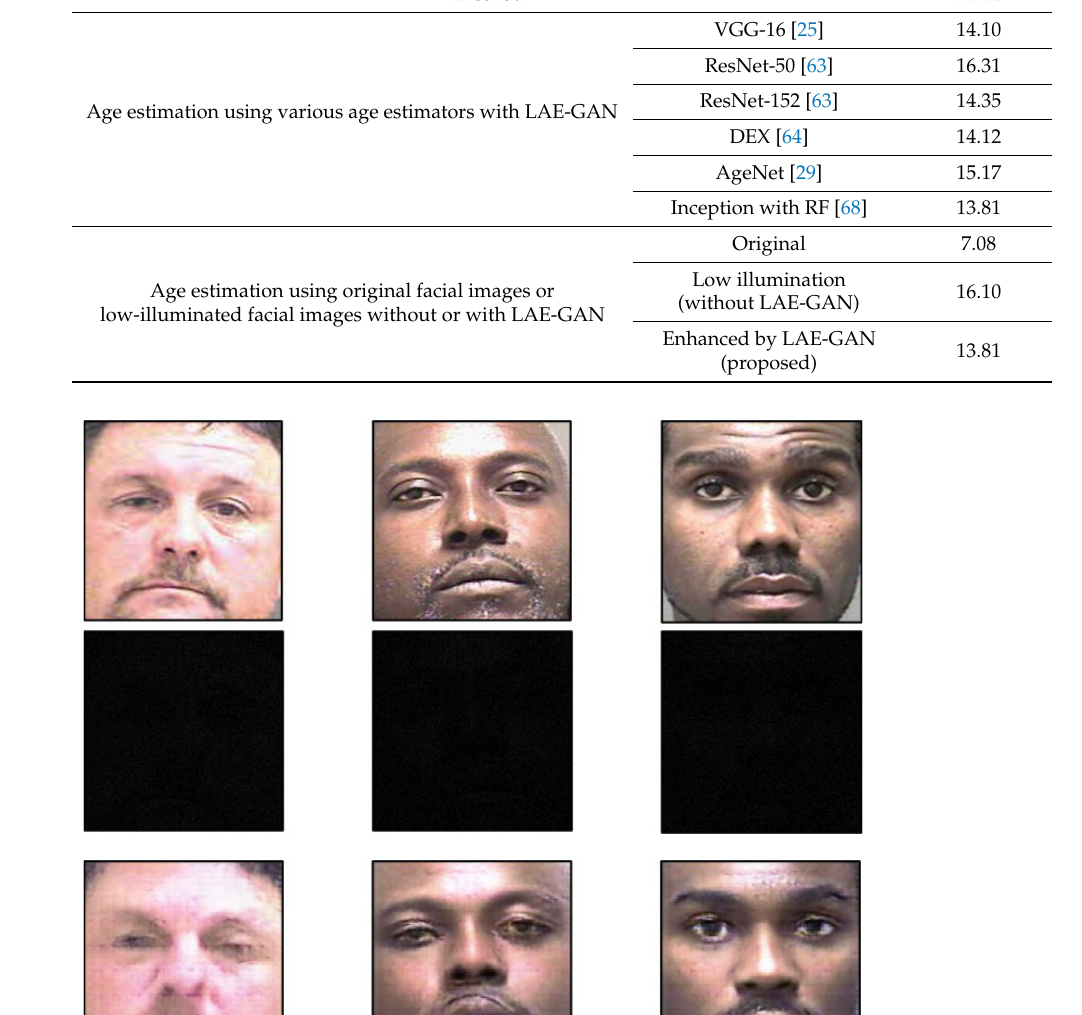
Table 7. Comparisons of age estimation accuracies by various methods on the AFAD database (unit: years). Method